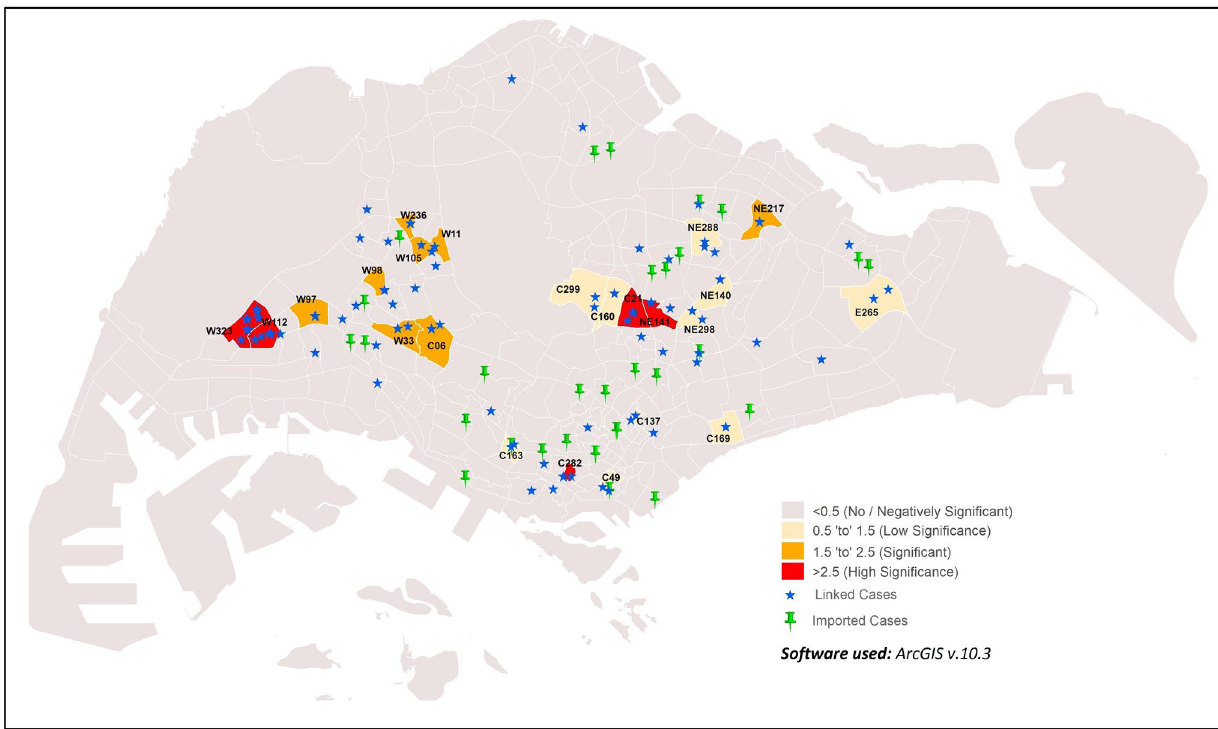
Figure 8. Distribution of sub-zones with correlation of imported and linked cases.